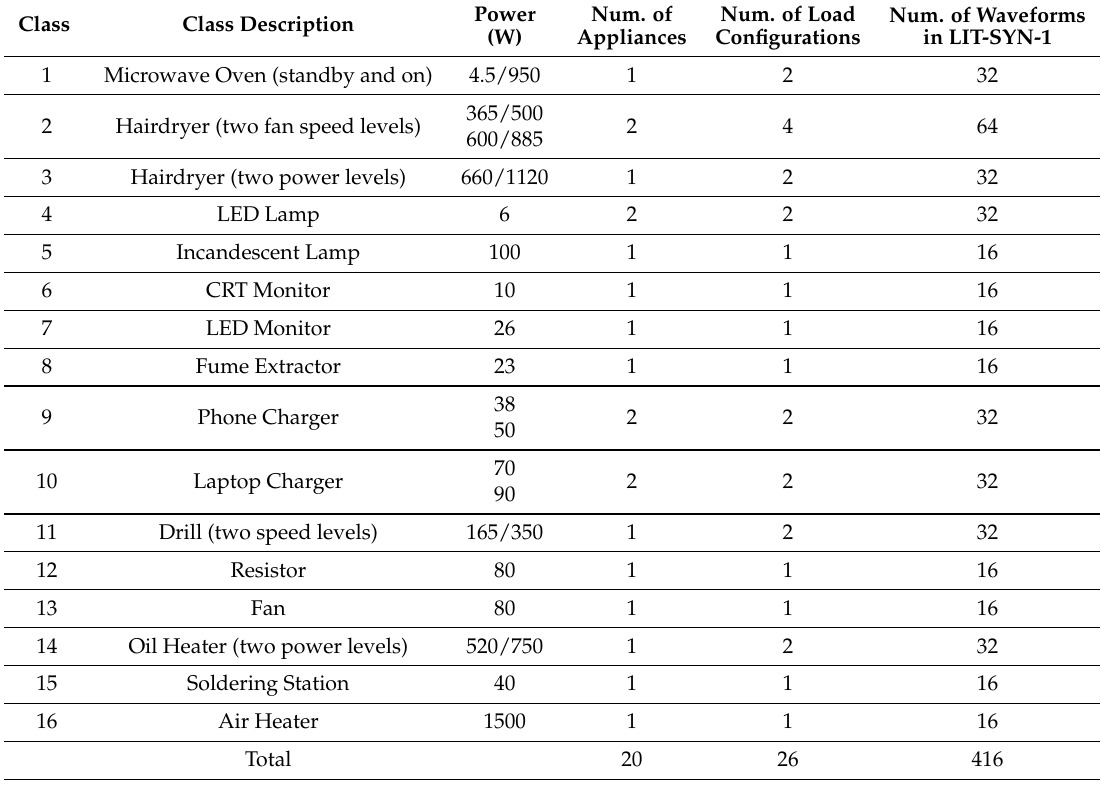
Table 5. Characteristics of the synthetic subset of the LIT-dataset.